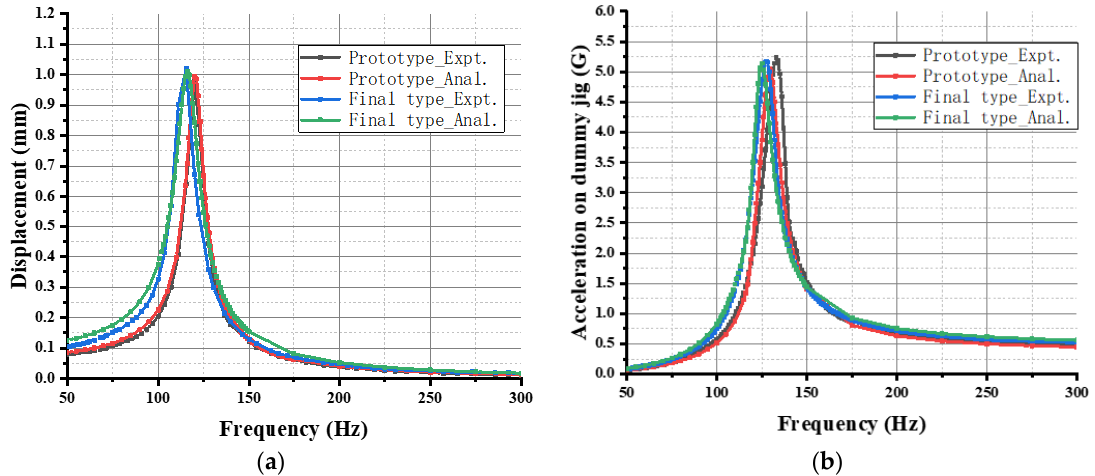
Figure 9. Displacement and acceleration comparison: ( a ) displacement results and ( b ) acceleration results.